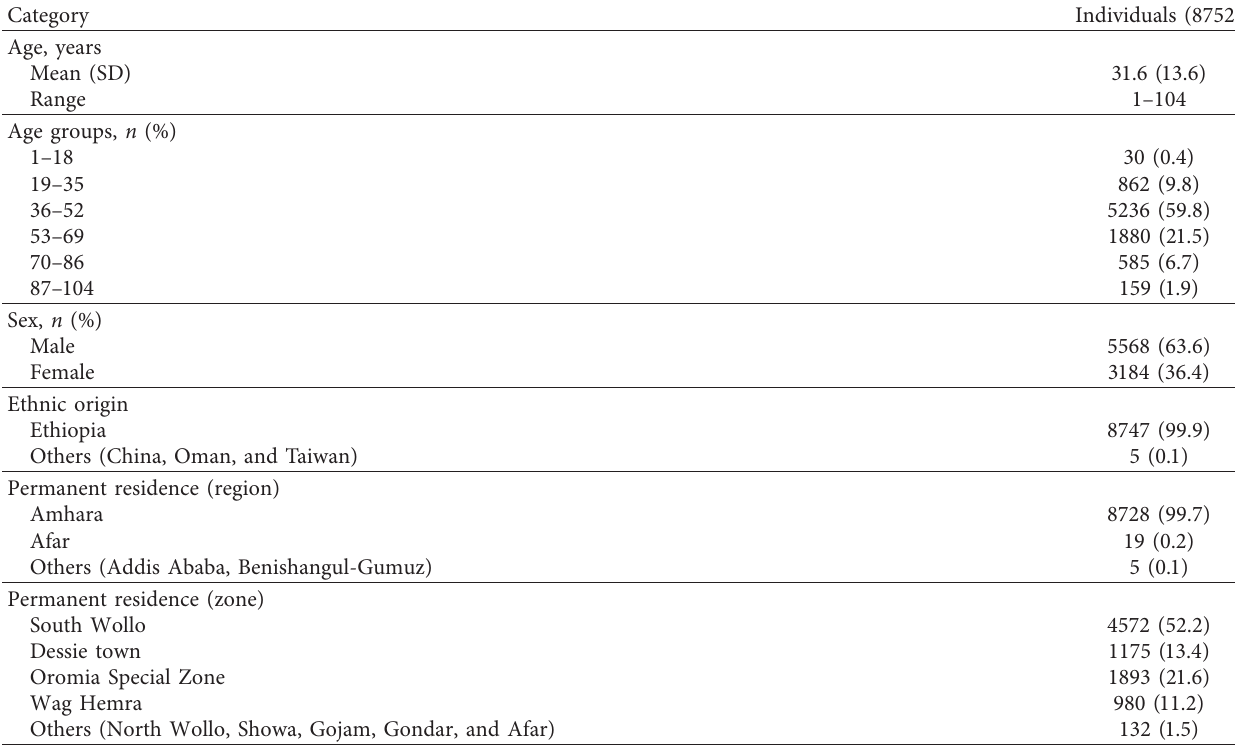
Table 1: Sociodemographic characteristics of the study participants in the northeastern region of Ethiopia, 2020.